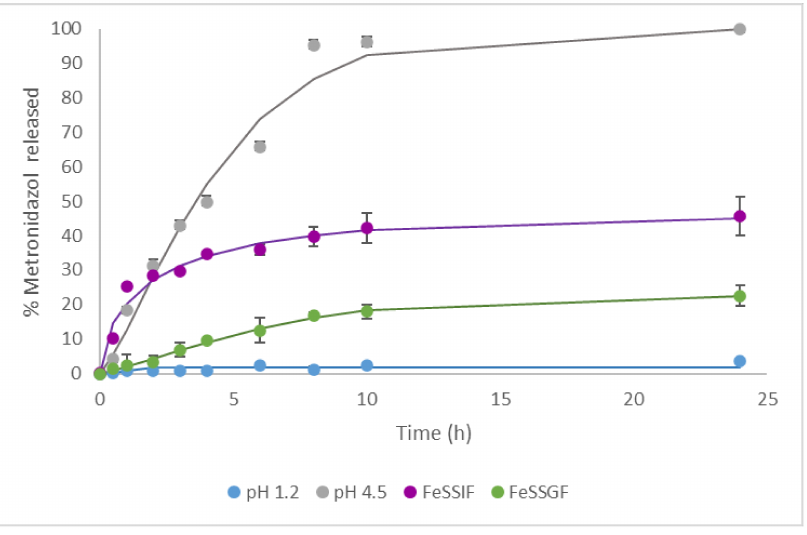
Figure 4. Metronidazole release kinetics from a suspension of mesoporous silica microparticles, functionalized with N3 and loaded with metronidazole (MCM-Met-N3) at different pHs and in the presence of different simulated